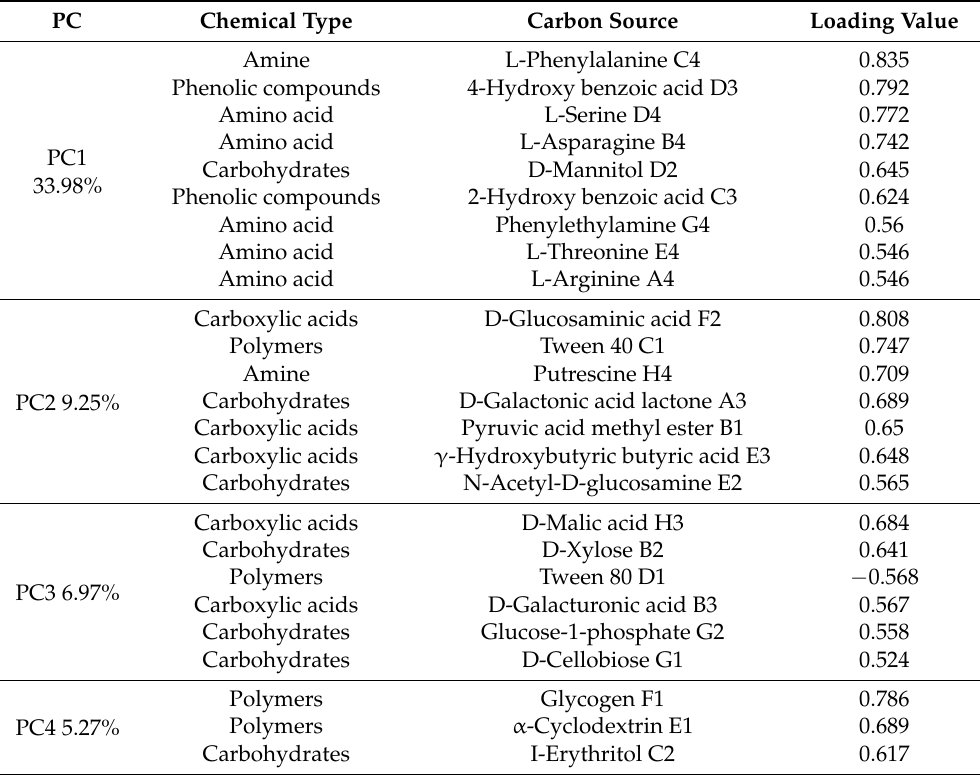
Table 2. Loading factors of principal components (PCs) of different carbon sources at 96